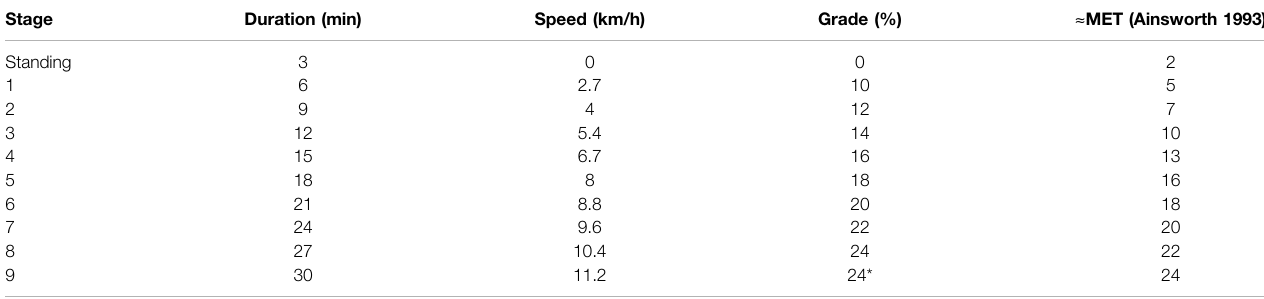
TABLE 1 | Bruce test protocol